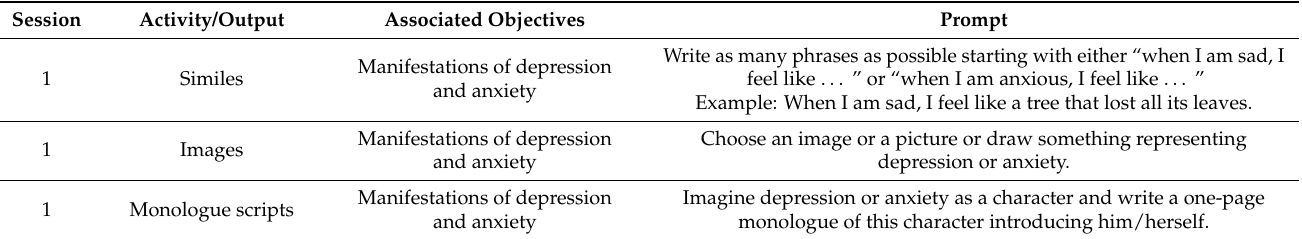
Table 1. Artistic outputs from the